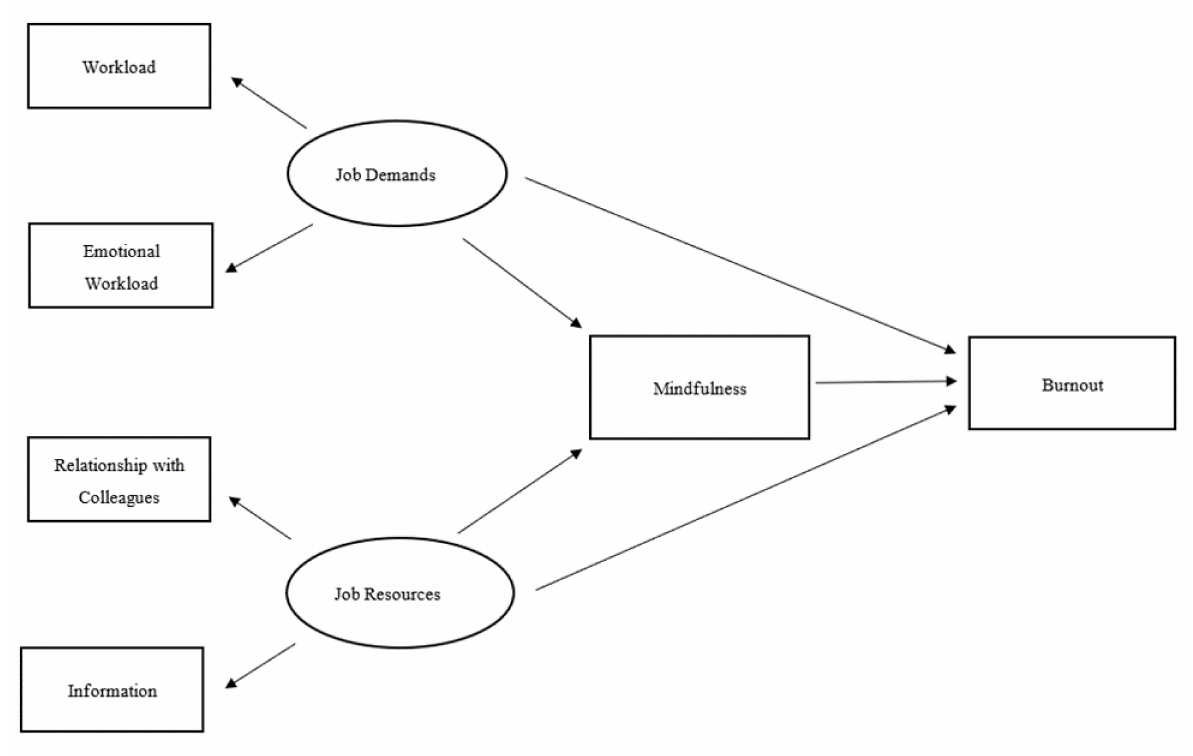
Figure 1. Conceptual model of JD-R, mindfulness, and